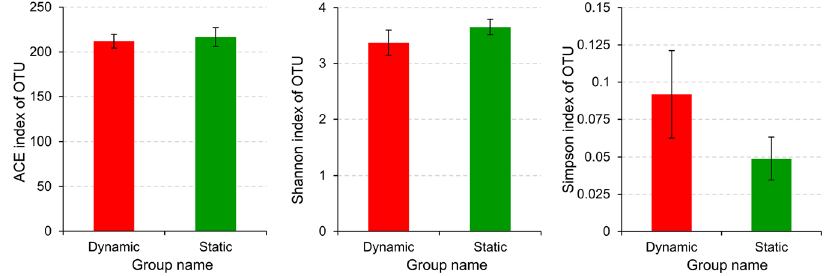
Figure 2. Statistical comparisons of the ACE, Shannon, and Simpson indices between static and dynamic water flow conditions, with the p values estimated to be 0.567, 0.141, and